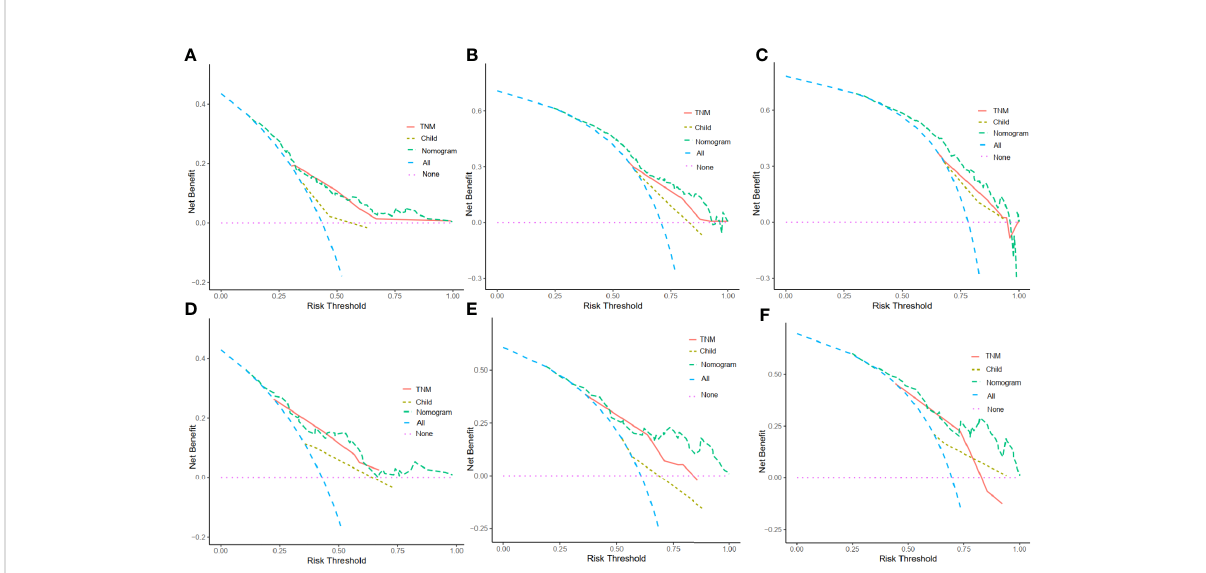
FIGURE 6 Decision curve analysis (DCA) for the nomogram. The y-axis represents net bene fi ts, calculated by subtracting the relative harms (true positives) from the bene fi ts (false positives). The x-axis measures the threshold probability. (A) DCA in the training cohort at 1 year. (B) DCA in the training cohort at 3 years. (C) DCA in the training cohort at 5 years. (D) DCAin the validation cohort at 1 year. (E) DCA in the validation cohort at 3 years. (F) DCA in the validation cohort at 5